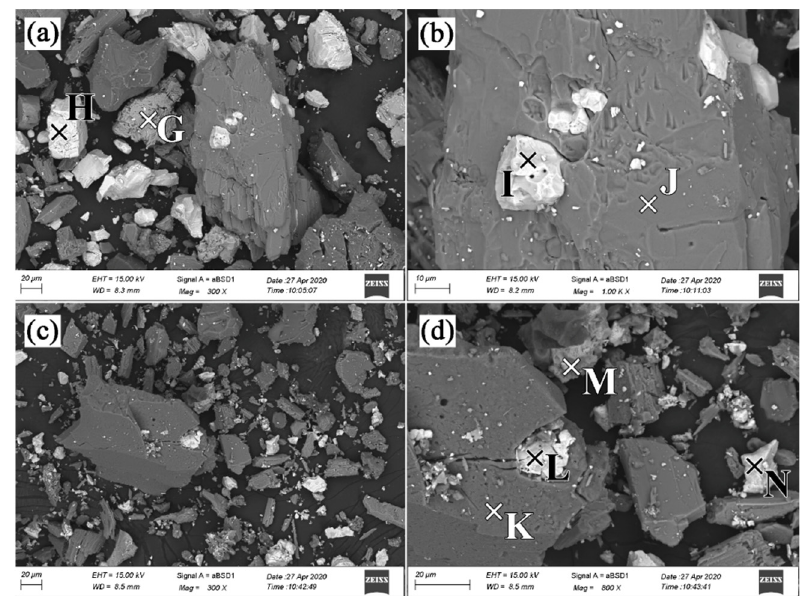
Figure 9. SEM image of the leaching residues of samples roasted at different temperatures for 120 min: ( a , b ) 600 °C, ( c , d ) 750 °C; H, L, and N are BaSO 4 ; J and K are Na(Fe, Sc)Si 2 O 6 ; G and M are niobium minerals; I is REPO 4 .